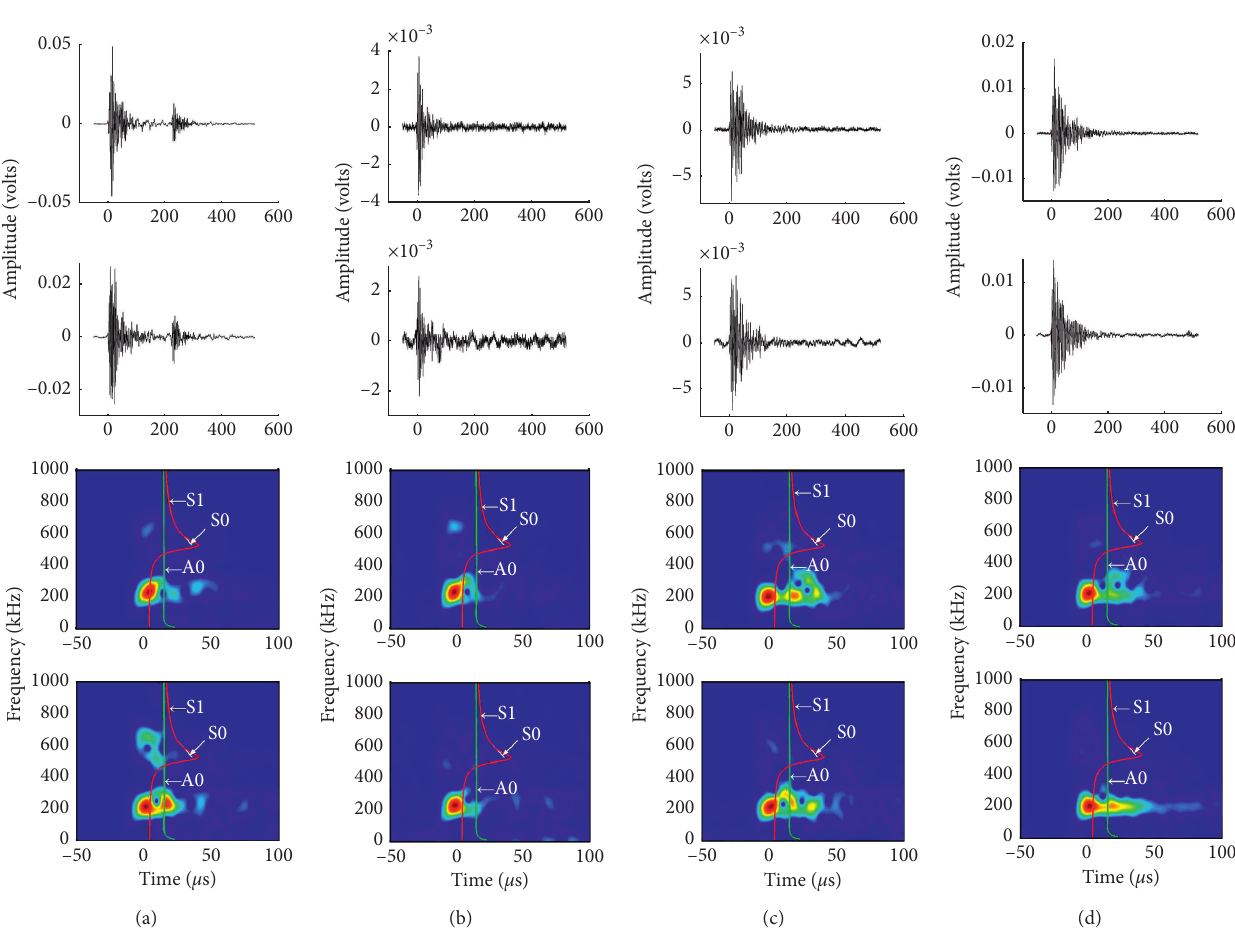
� 34.8s. (b) t � 87.2 s. (c) t � 138.3s. (d) t � 4 ] s layup. (a) t